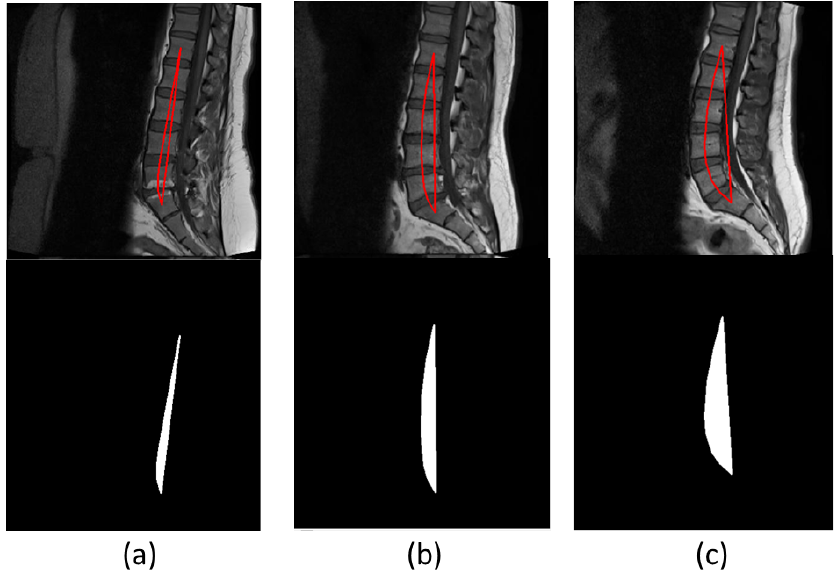
Figure 15. Each column represents the region plot of an image and its respective area computation image. ( a – c ) represent the hypolordosis, normal lordosis, and hyperlordosis cases, respectively. Each image has different curve and area which differentiates the